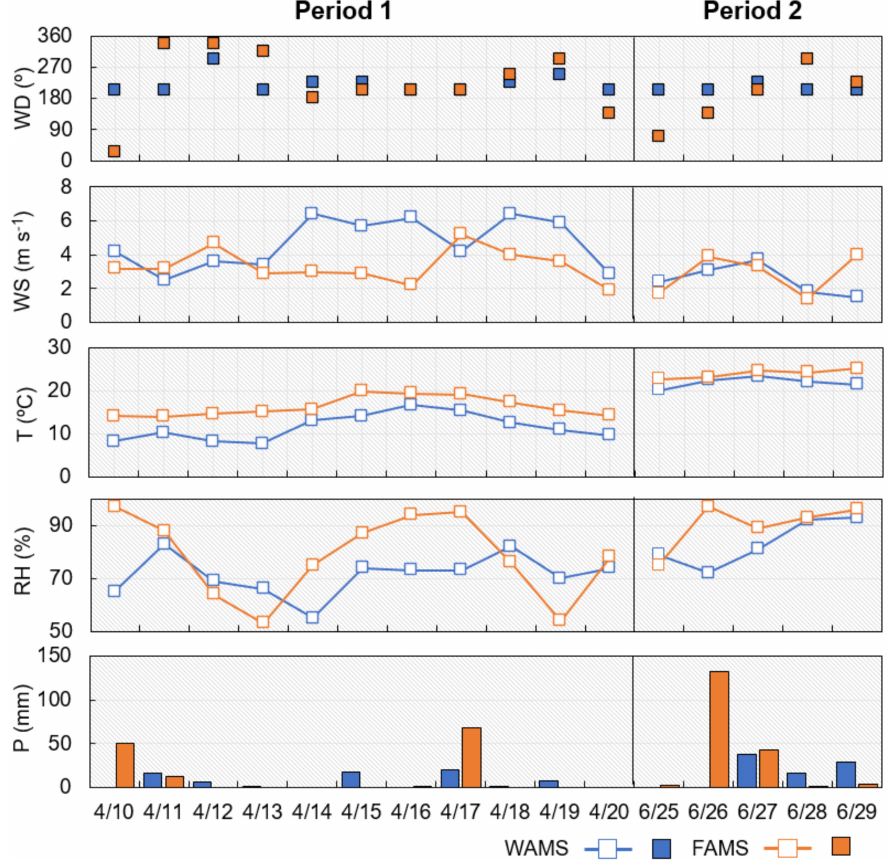
Figure 3. Meteorological conditions at WAMS and FAMS in the East Asian winter monsoon period (Period 1, 10–20 April 2017) and summer monsoon period (Period 2, 25–29 June 2019). P, RH, T, WS, and WD are precipitation, relative humidity, temperature, wind speed, and wind direction,